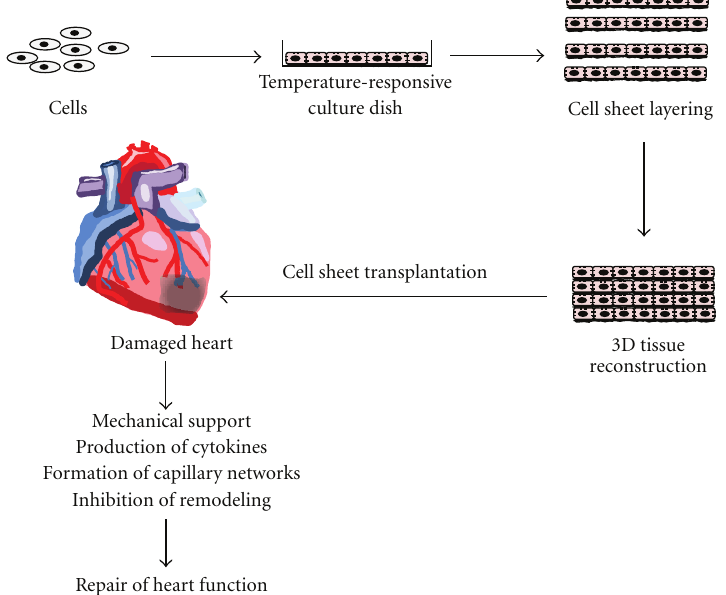
Figure 2: Sca ff old-free cell sheet-based tissue engineering: the fabrication of 3D myocardial tissue, transplantation, and the therapeutic e ff